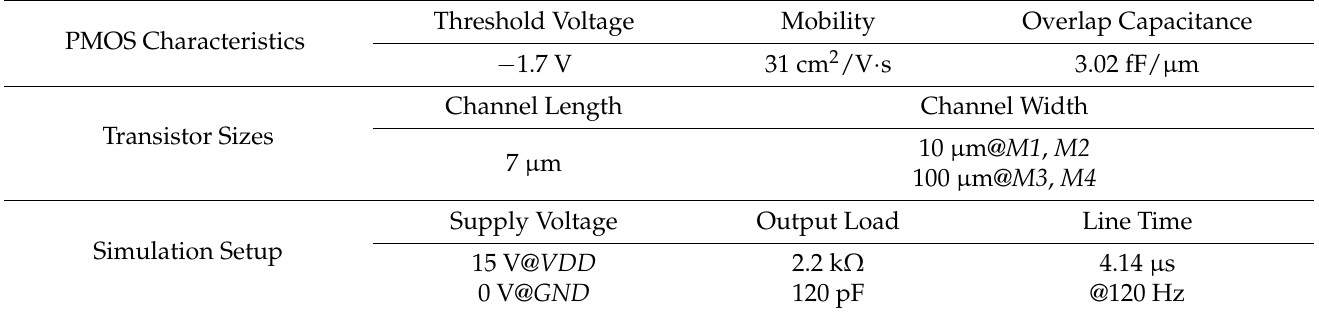
Table 1. Parameters for emission ( EM ) circuit